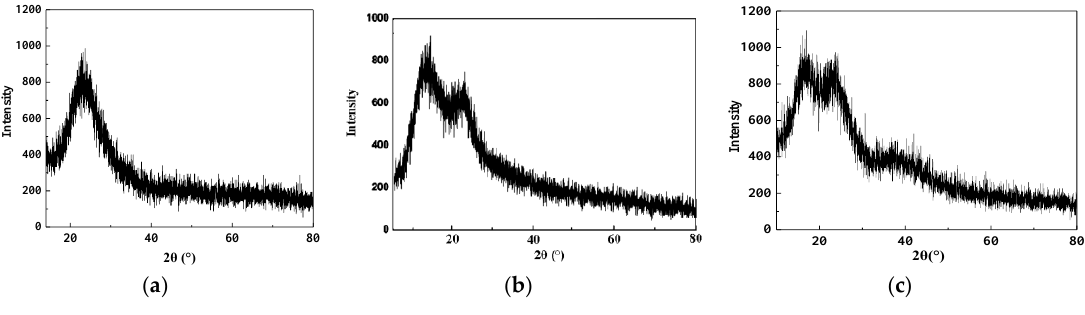
Figure 4. XRD spectra: ( a ) SiO 2 sol, ( b ) FVPS, and ( c ) FSi@SiO 2 .